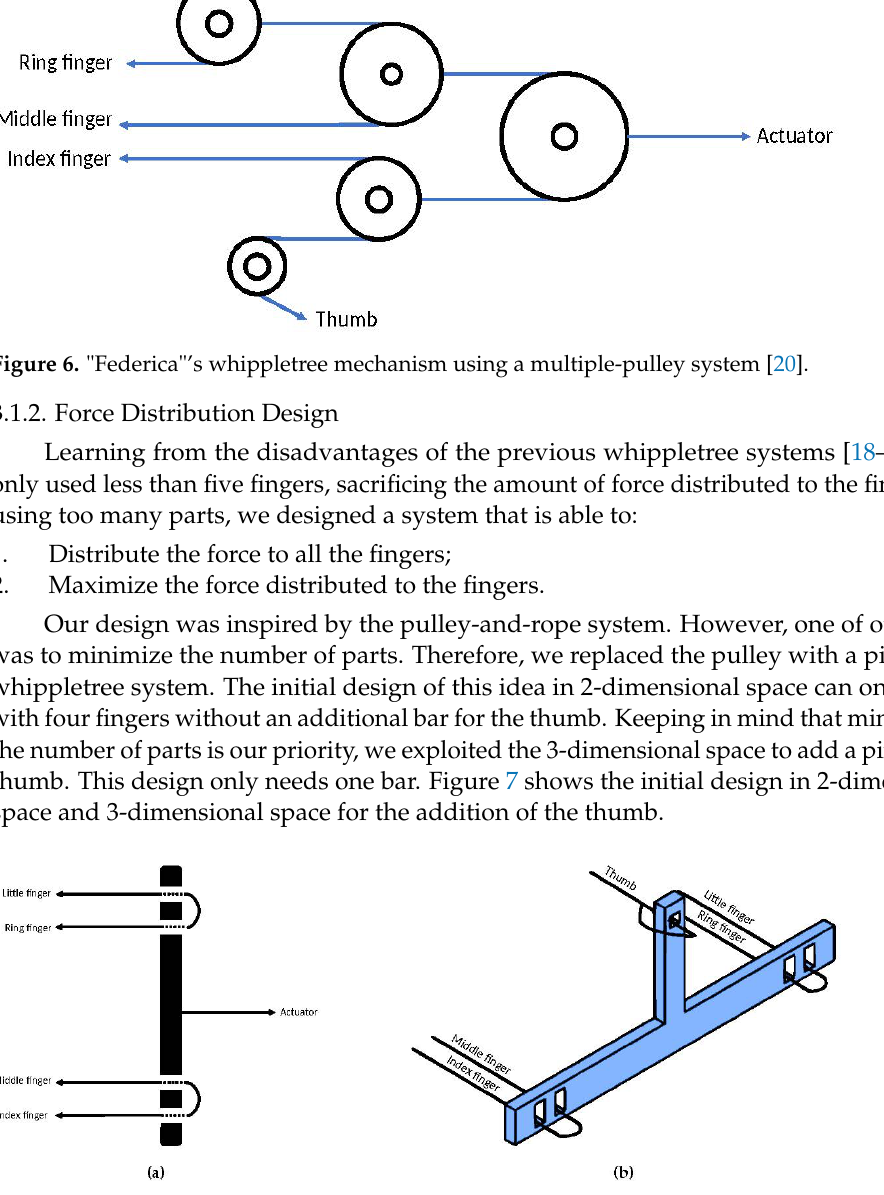
Figure 7. ( a ) Our initial design in 2-dimensional space and ( b ) 3-dimensional space design for the accommodation of the